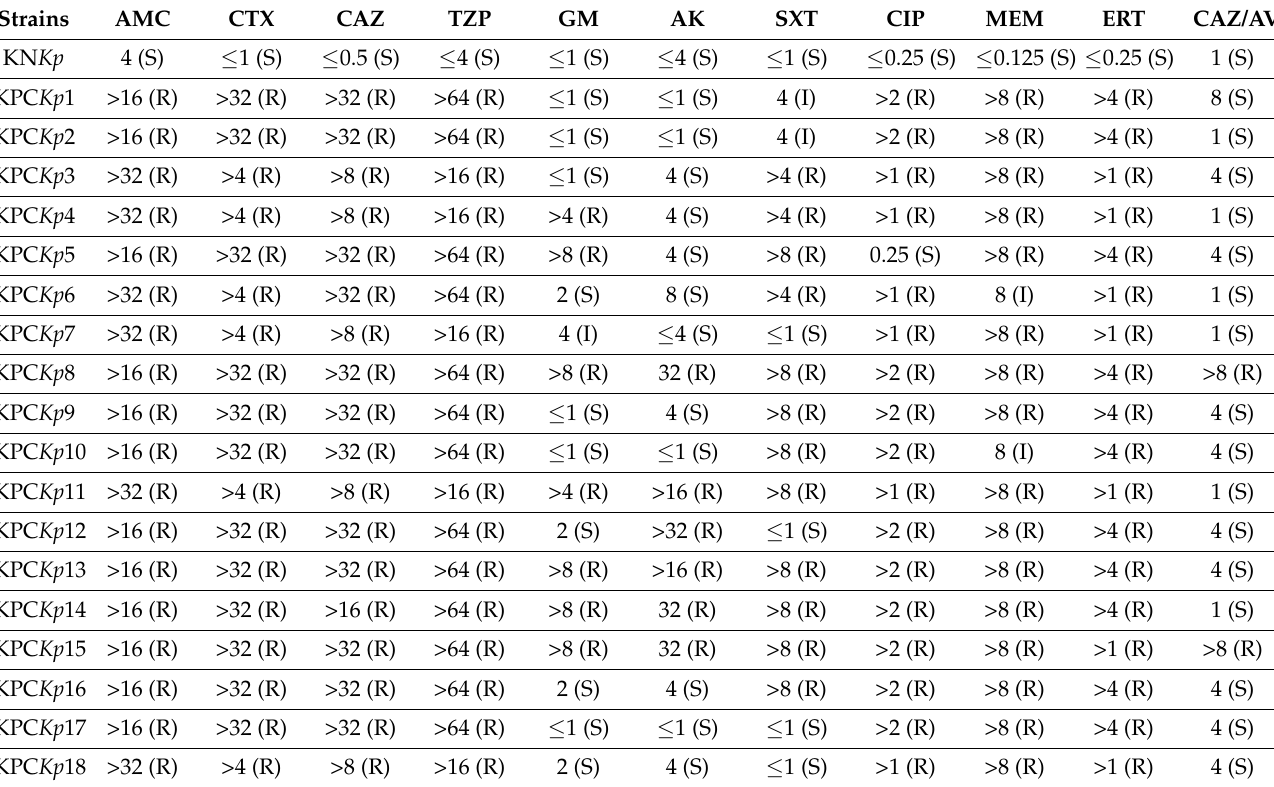
Table 2. Antibiotic-susceptibility profile of K. pneumoniae clinical